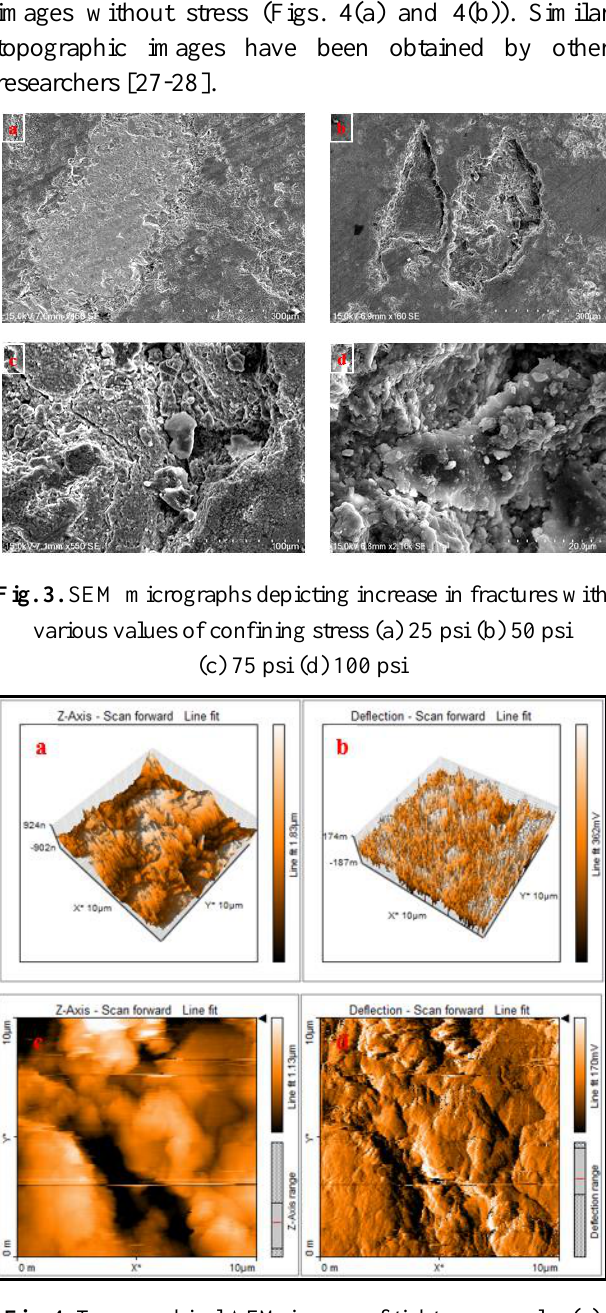
Fig. 4. Topographical AFM images of tight gas samples (a) Surface roughness, without confining stress (b) 3D image without confining stress (c) 3D image, confining stress 100 psi (b) surface roughness, confining stress 100 psi